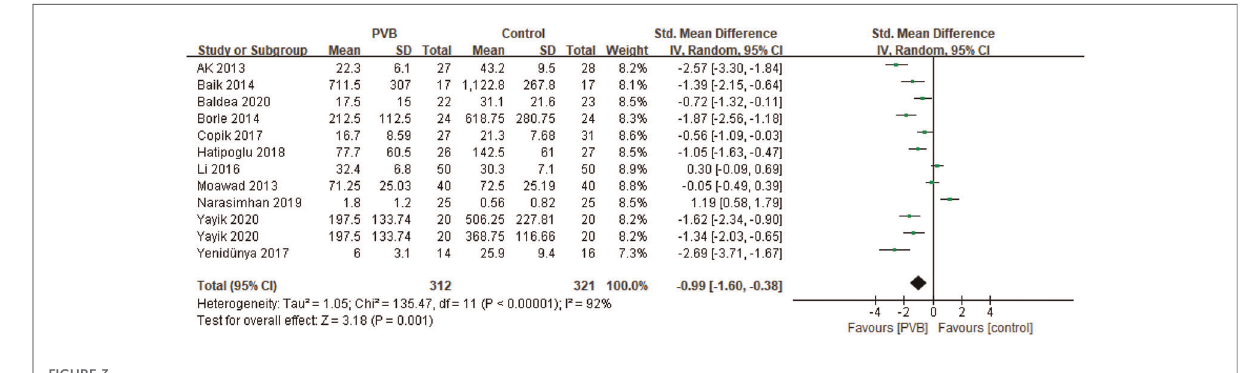
FIGURE 3 Forest plot of 24-hour postoperative opioid